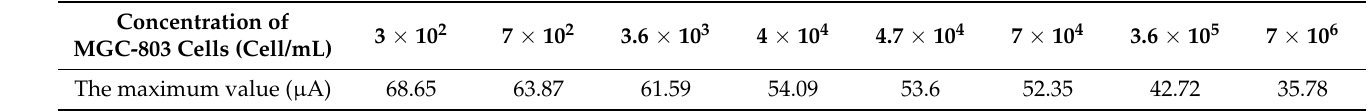
Table 1. The DPV currents of GO-AuNSs@rBSA-FA-labeled electrodes for various concentrations of MGC-803 cells.